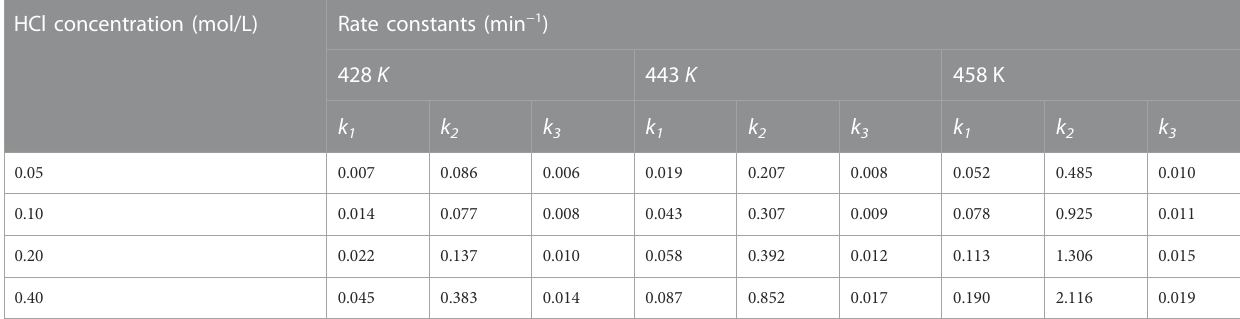
TABLE 1 The rate constants of the reactions 1 – 3 in Scheme 1 at different reaction temperatures and acid concentrations. HCl concentration (mol/L)